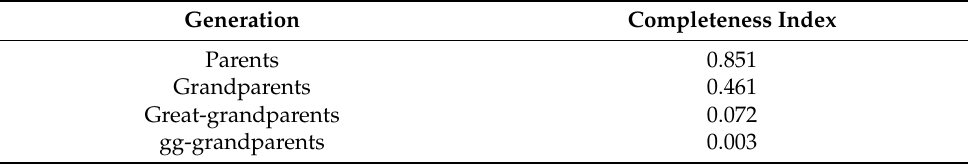
Table 1. Pedigree completeness index for the known generations in Nero Lucano pigs.